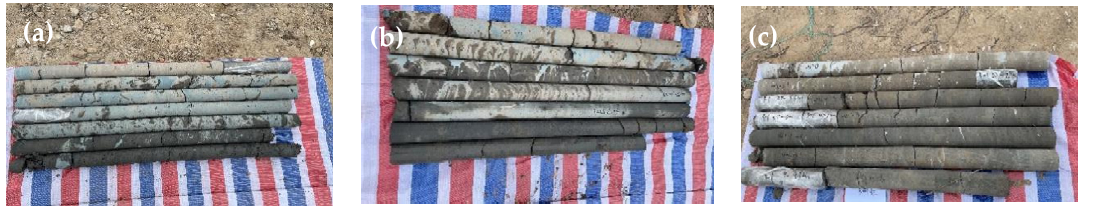
Figure 6. Influence of mixing times on oozing slurry of a mixing pile: ( a ) two, ( b ) four and ( c ) six.